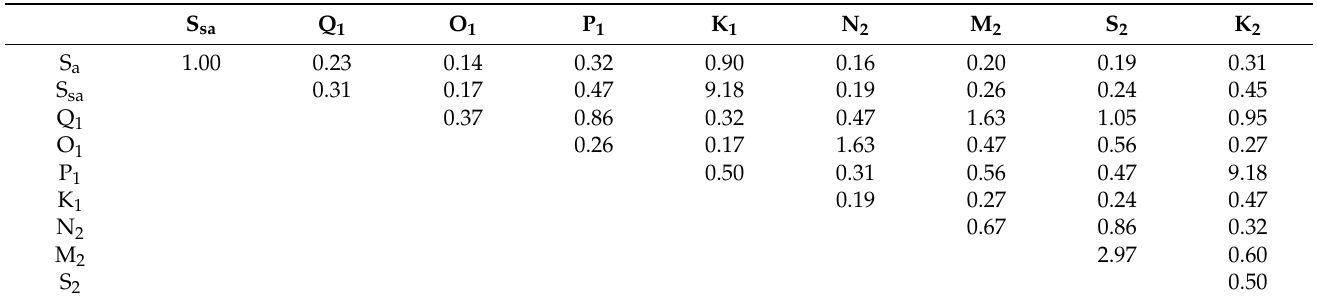
Table 3. Minimum length (years) for resolving each pair of constituents from T/P-Jason altimetry observations